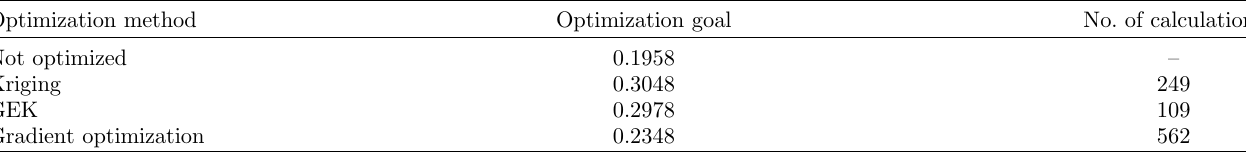
Table 5. Comparison of optimization methods at full